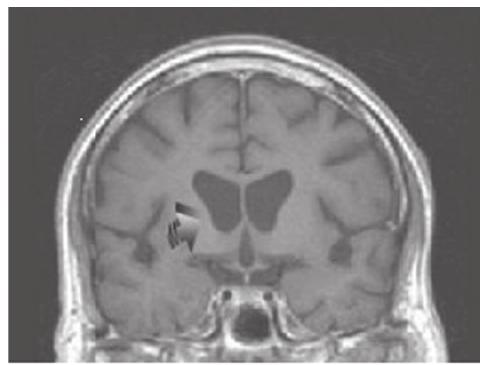
Figure 3 - Caudate atrophy on brain